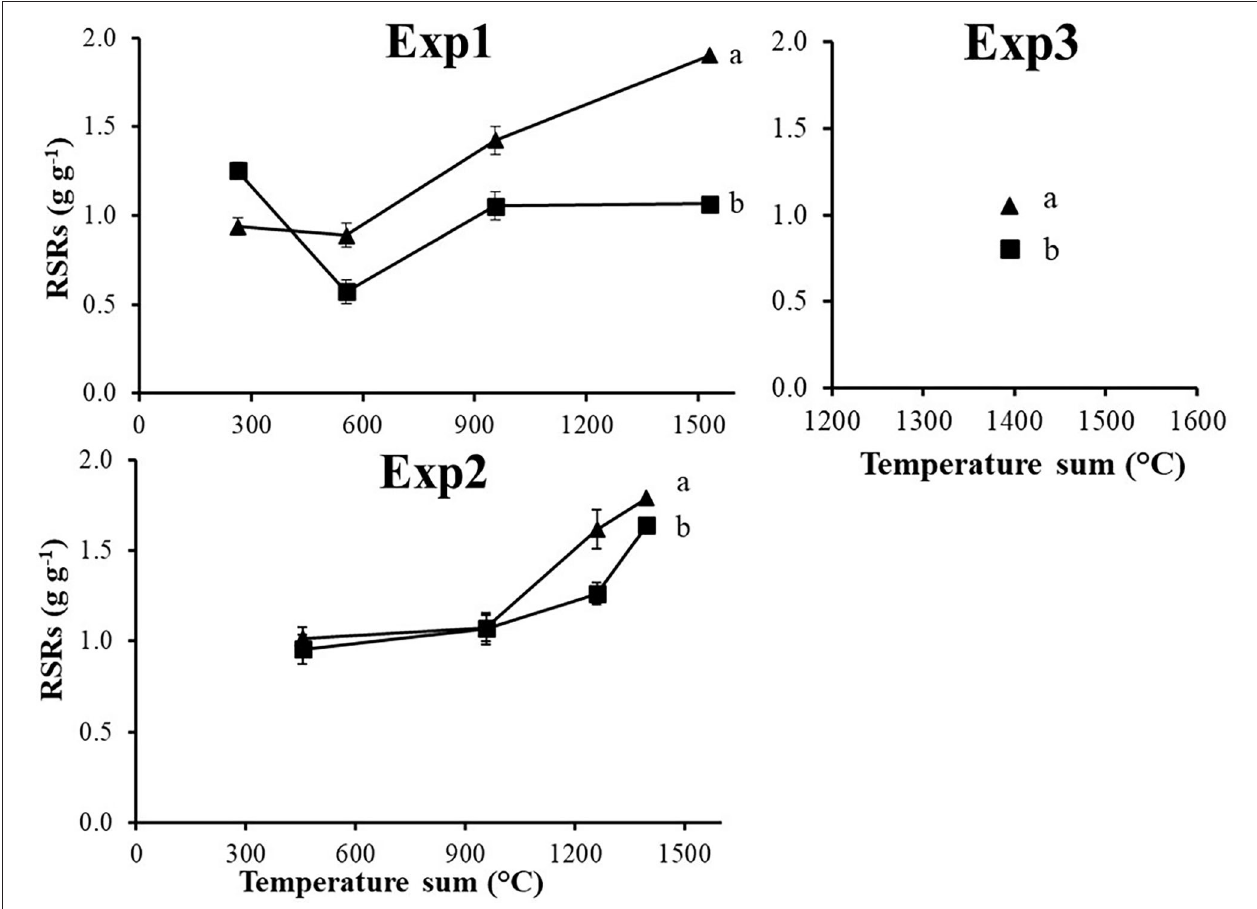
FIGURE 7 | Root shoot ratio system (RSRs) calculated for the three experiments in relation to the resistance status: S ( (cid:4) ) and R ( N ). Vertical bars represent standard errors. Different letters indicate significant differences ( P ≤ 0.05) according to Fisher’s LSD test.